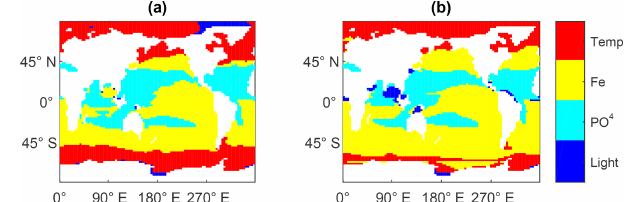
Figure 8. Spatial distribution of the most limiting factors for growth of diazotrophs for (a) the pre-industrial case and (b) simulation year 5000 for Weath0.15 . Limitation of iron (Fe) and phosphate (PO 4 ) is based on Monod kinetics so that the limitation factors vary between 0 and 1. The light limitation factor also varies between 0 and 1. In the model, diazotrophs only grow at temperatures higher than 15.7 ◦ C. For temperatures above 15.7 ◦ C, diazotroph growth depends on the equation exp( T/ 15 . 7 ◦ C) − 2 . 61. Diazotroph growth is not limited by nitrate availability in the model. A more detailed description of diazotroph growth and iron limitation can be found in Keller et al. (2012) and Nickelsen et al.